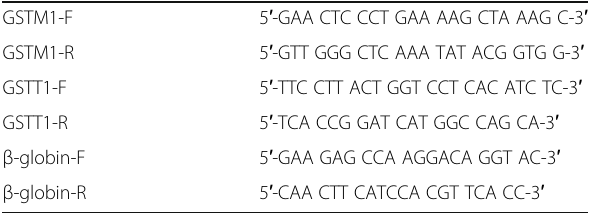
Table 1 PCR primers for GSTT1, GSTM1